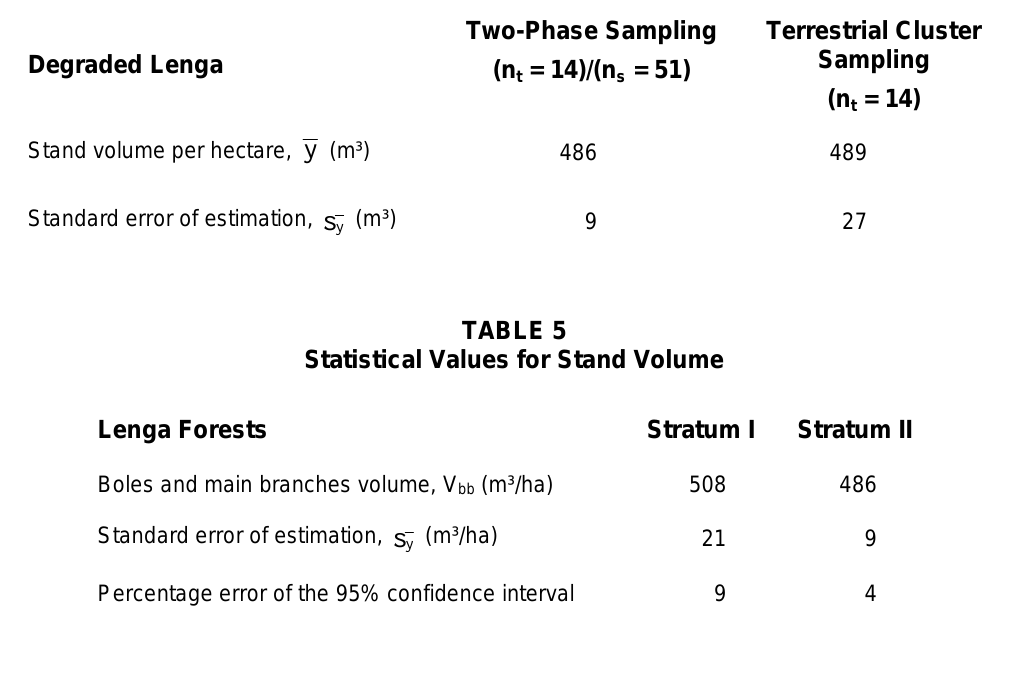
Statistical Values for Stand